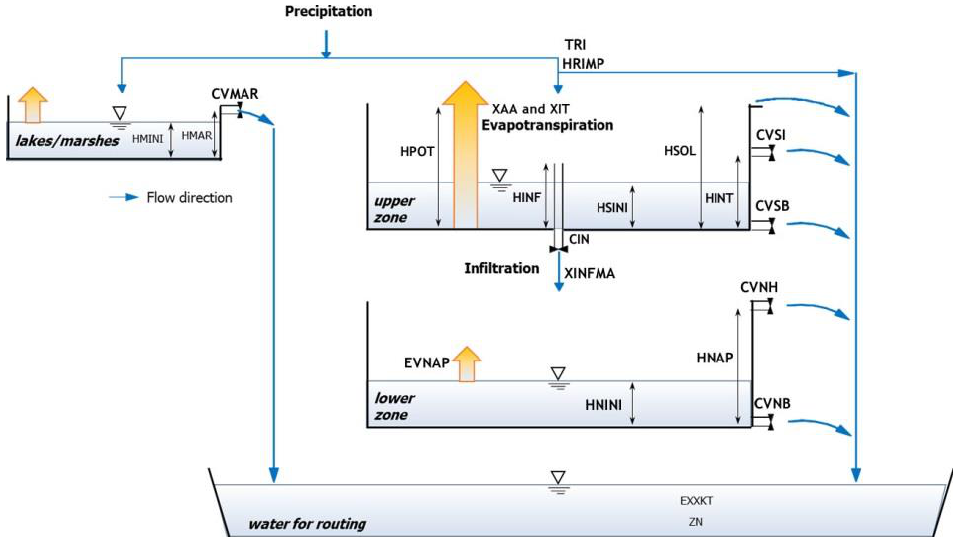
Figure 2. Scheme and parameters of CEQUEAU hydrological model.